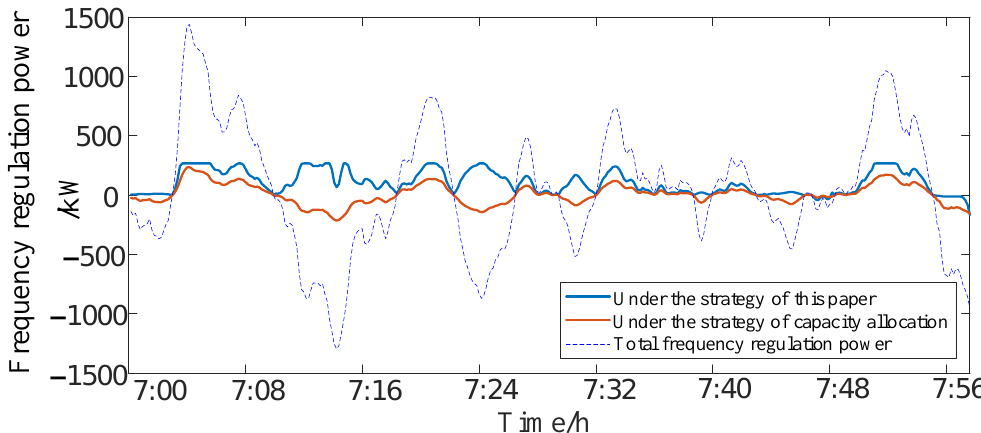
Figure 7. Comparison of FR power of BSS 3 under the strategy of this paper and the strategy of capacity allocation distribution based on capacity.